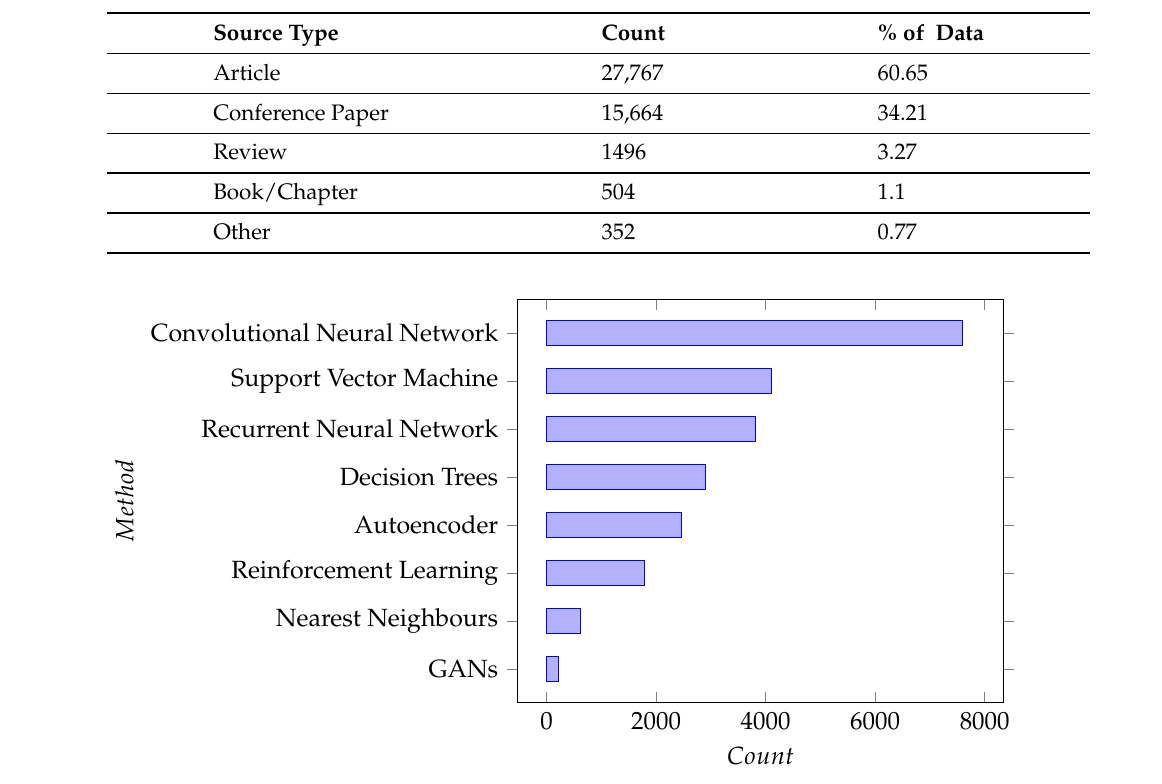
Table 1. Paper sources for corpus.